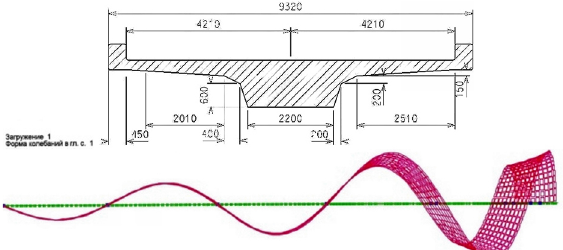
Fig. 8. Cross section and first mode shape of a South bridge overpass Nr. 5–2. FE model constructed as a plate 3D system